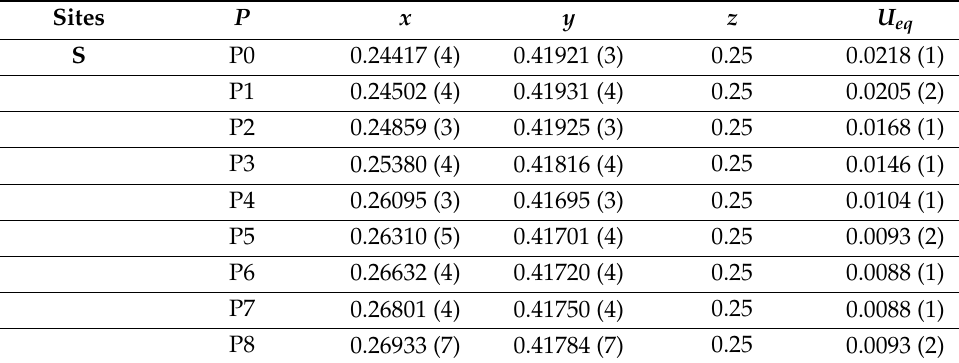
Table 2. Atomic coordinates and U eq for all non-H-atoms (Å 2 ) of (NH 4 ) 2 SO 4 at different pressures. P values are given in Table